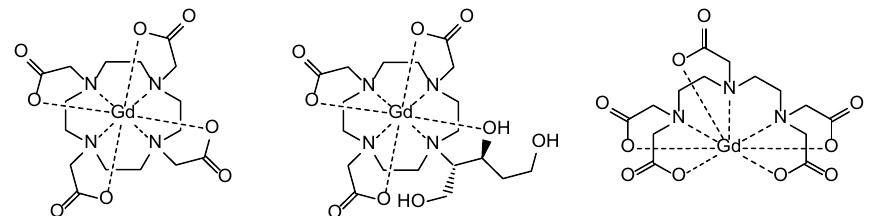
Fig. 1 Gadolinium contrast agents (left to right) Gd-DOTA, Gadolinium(III)-tris(carboxymethyl)-1,4,7,10-tet raazacyclododecane-butriol (Gd-BT-DO3A) and Gadolinium(III)-diethylenetriaminepentaacetic acid (Gd-DTPA)